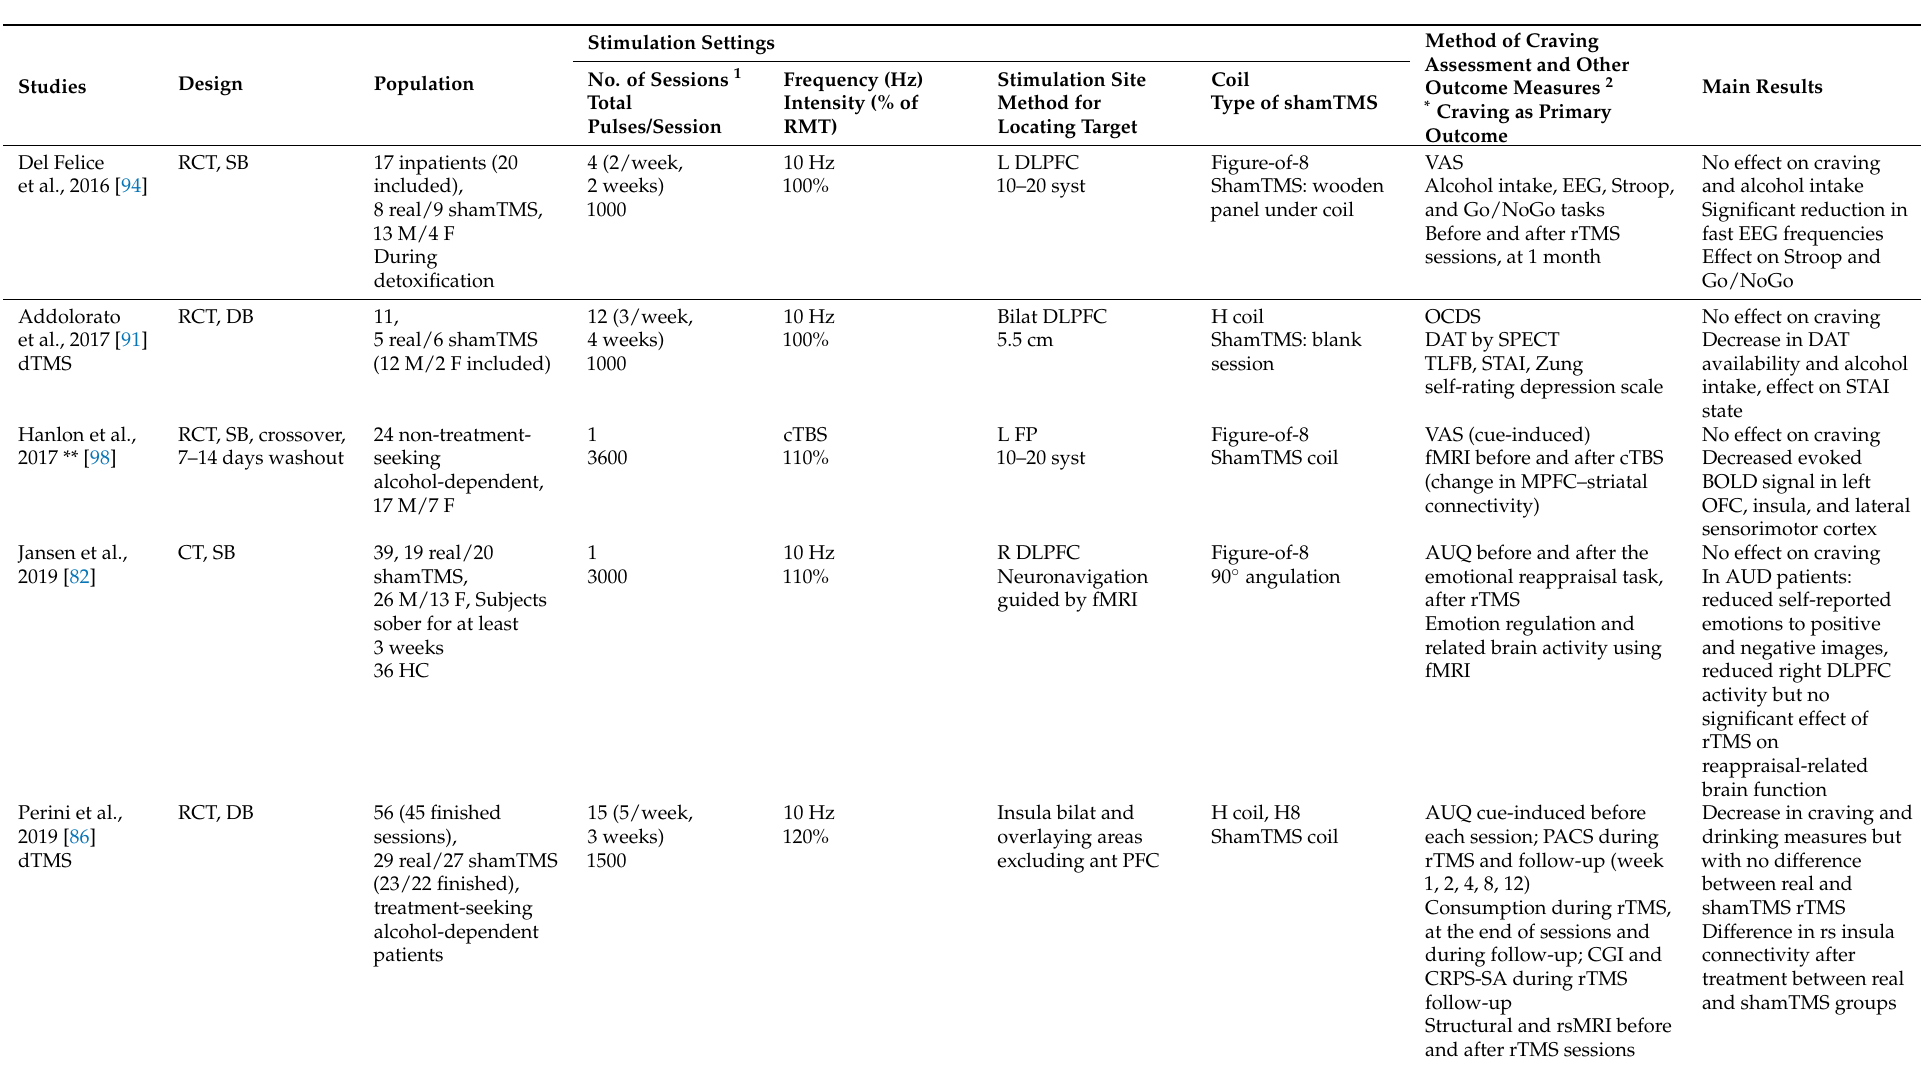
shamTMS rTMS Difference in rs